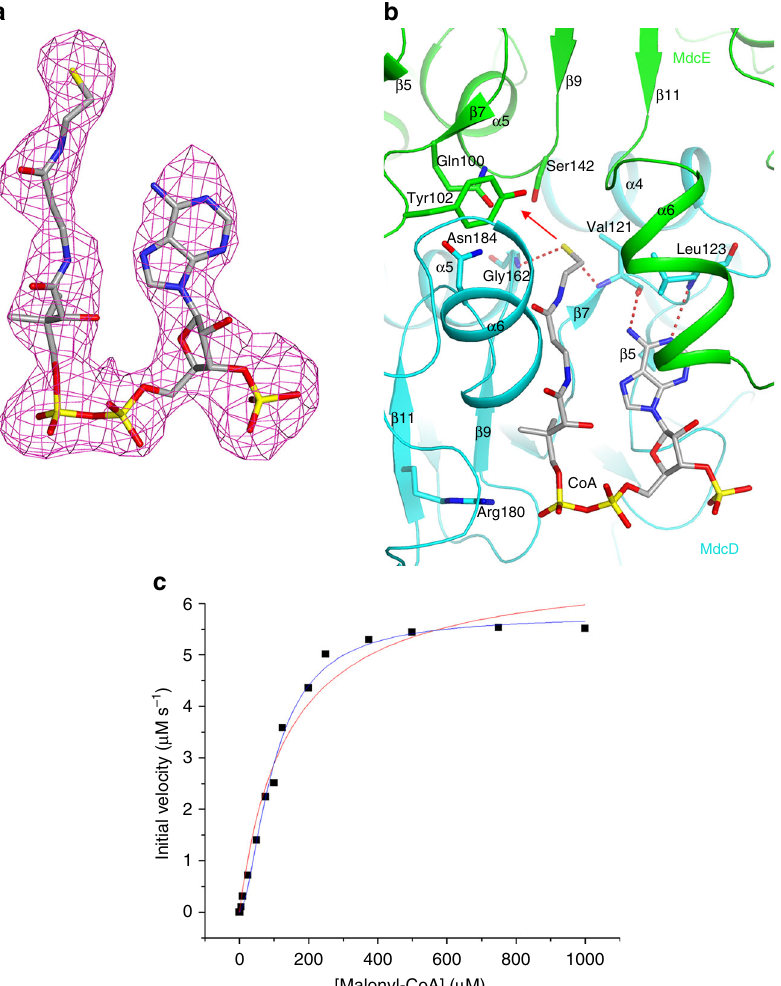
Figure 6 The active site of MdcD – MdcE. a Simulated-annealing omit F o − F c electron density map at 3.0 Å resolution for CoA in the active site of MdcD – MdcE, contoured at 3 σ . b Residues in the active site of MdcD – MdcE. Interactions between CoA ( gray ) and MdcD – MdcE are shown. Hydrogen- bonding interactions are indicated with dashed lines ( red ). The possible binding site for the malonyl group is indicated with the red arrow. c MdcD – MdcE demonstrates cooperative behavior towards malonyl-CoA. The initial velocity data are fi tted to the Hill equation to obtain the kinetic parameters ( blue curve ). The Michael – Menten equation does not produce as good a fi t to the data ( red curve ). Data from one representative set of experiments are